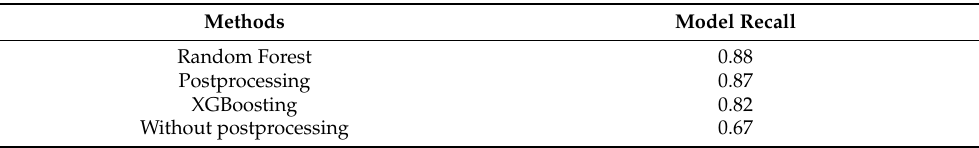
Table 6. Final recall of different methods on the dataset from [16].